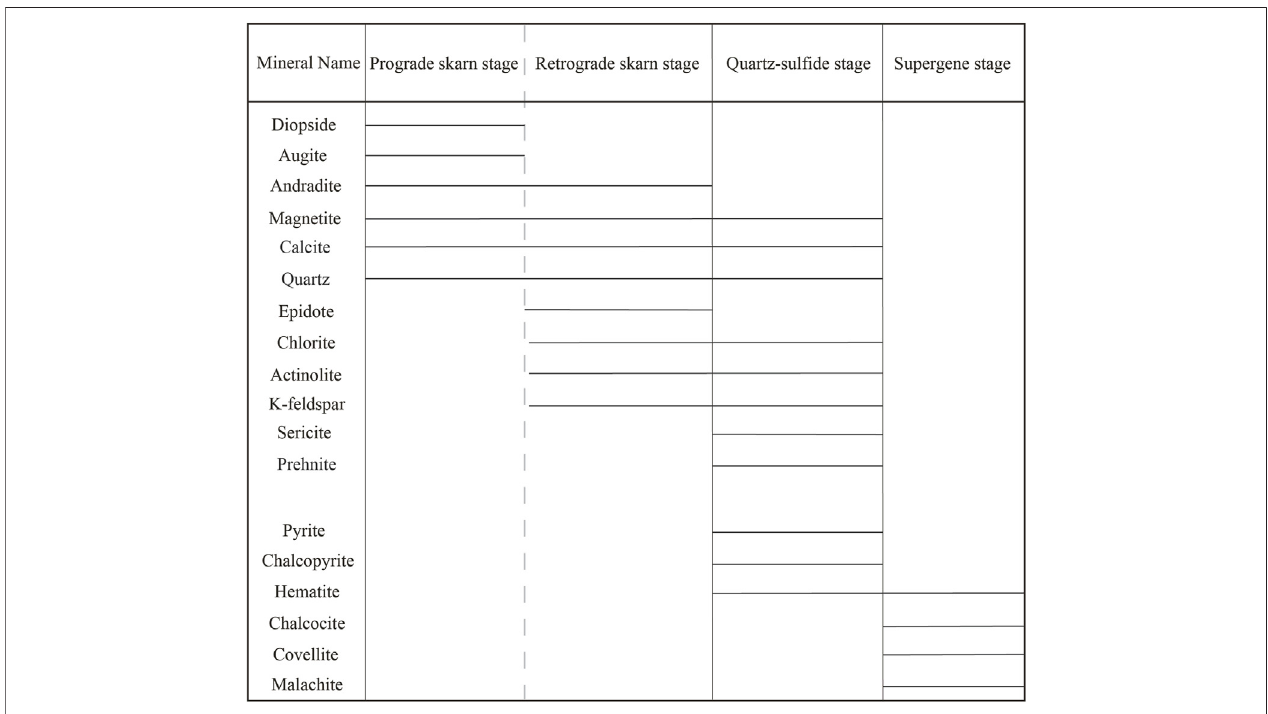
FIGURE 3 | Paragenetic sequence for the four stages of the Fe – Cu mineralizationin Qiaer ’ dunbasixi deposit (modi fi ed from Wang and Zhu, 2010).